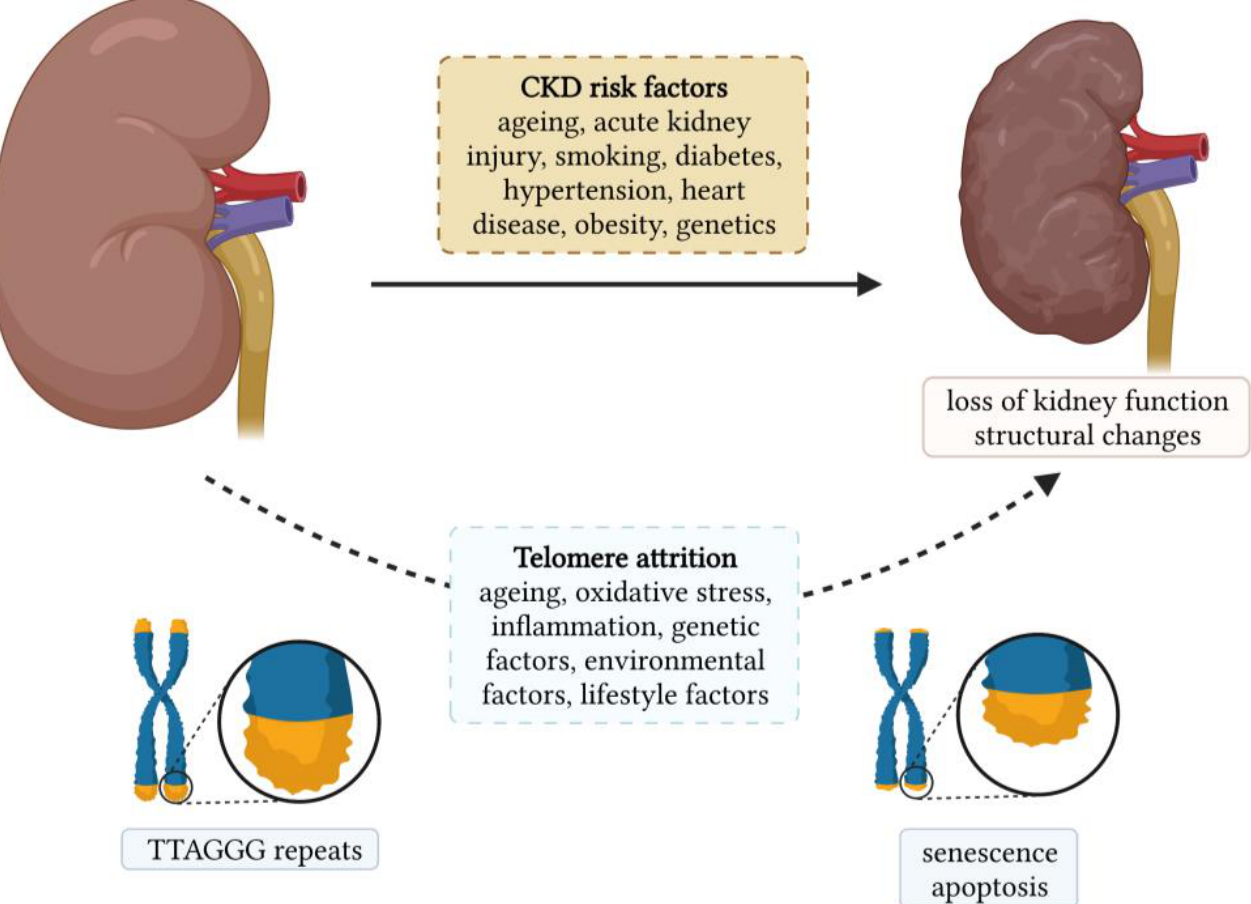
Figure 1. Chronic kidney disease and its association with telomere length.